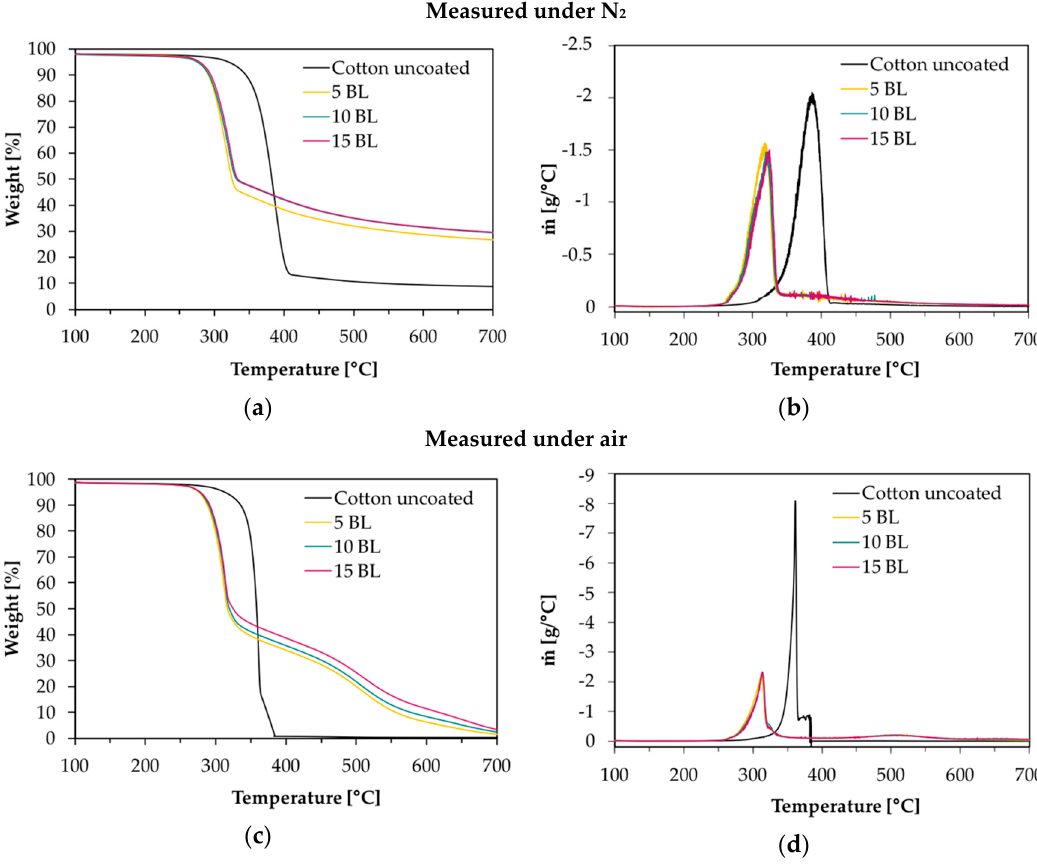
Figure 2. Thermogravimetric analysis (TGA) curves of coated and uncoated cotton fabrics, measured under nitrogen and air with 20 K/min heating rate. ( a ) TGA curves in nitrogen; ( b ) differential TG (DTG) curves in nitrogen; ( c ) TGA curves in air; ( d ) overlapping DTG curves in air.